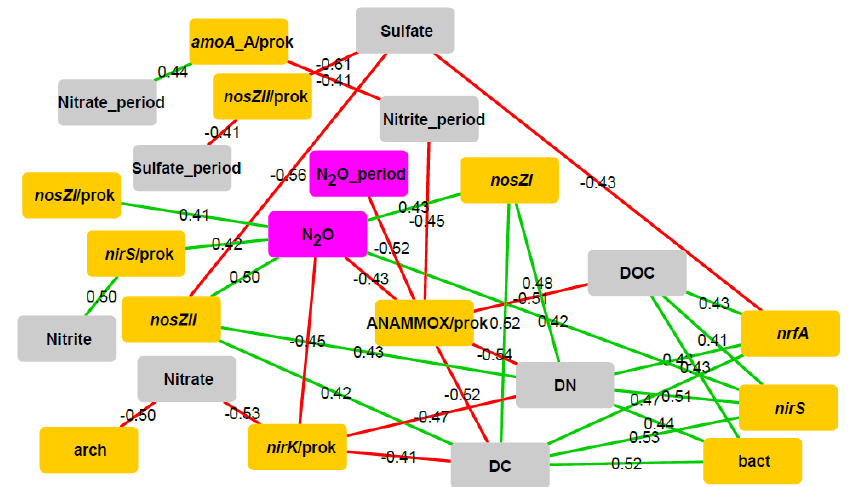
Figure 6. The Benjamini-Hochberg corrected Spearman correlation network ( p < 0.05) for each target gene parameter and environmental factor pair ( n = 42). Green is used to represent positive relationships, and red indicates negative relationships (exact R values are shown on the graph); yellow stands for gene abundances, grey for soil physicochemical variables and pink for gaseous parameters.